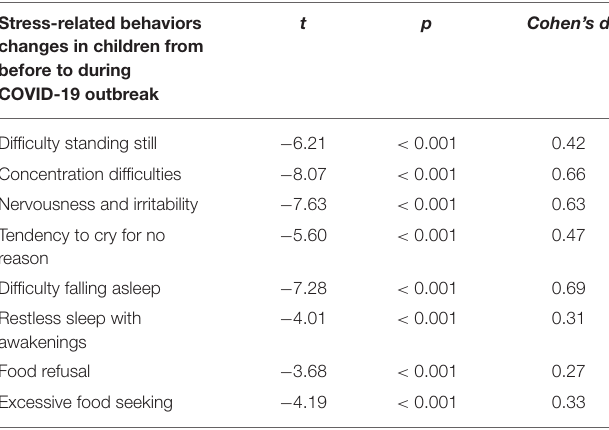
TABLE 4 | Comparison between child stress-related behaviors before and during COVID-19 outbreak. Stress-related behaviors changes in children